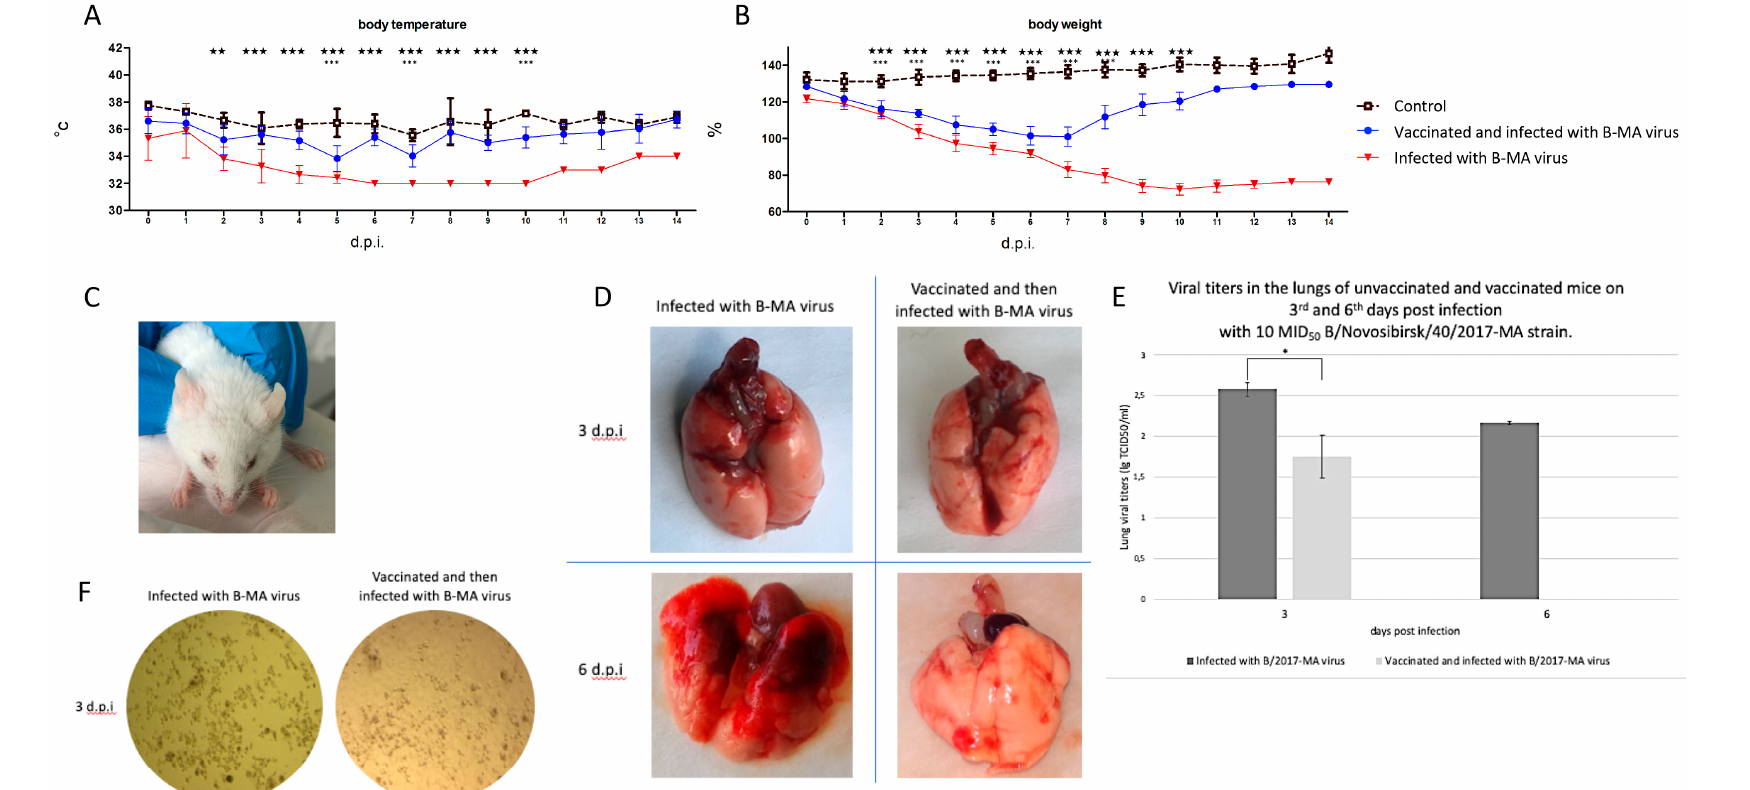
Figure 3. Assessment of vaccine e ffi ciency against mouse-adapted influenza B virus in vivo and in vitro. Note: ( A ) body temperature and ( B ) body weight of; intact mice received PBS (dotted black line); vaccinated and infected intranasally with 10 MID 50 of B / 2017-MA strain mice (dark blue line); infected intranasally with 10 MID 50 of B / 2017-MA strain mice (red line); (cid:63) p < 0.05; (cid:63)(cid:63) p < 0.01; (cid:63)(cid:63)(cid:63) p < 0.001, reliability when comparing data from groups of infected mice. ( C ) On day 3 day, conjunctivitis in a mouse infected with 10 MID 50 of B / 2017-MA strain. ( D ) Lungs of unvaccinated and vaccinated mice on 3rd and 6th days post infection with 10 MID 50 of B / 2017-MA strain. ( E ) Viral titers in the lungs of unvaccinated and vaccinated mice on 3rd and 6th days post infection with 10 MID 50 of B / 2017-MA strain. ( F ) Cytopathic e ff ect of Madin-Darby Canine Kidney (MDCK) cell culture on 3rd day post infection of unvaccinated and vaccinated mice with 10 MID 50 of B / 2017-MA